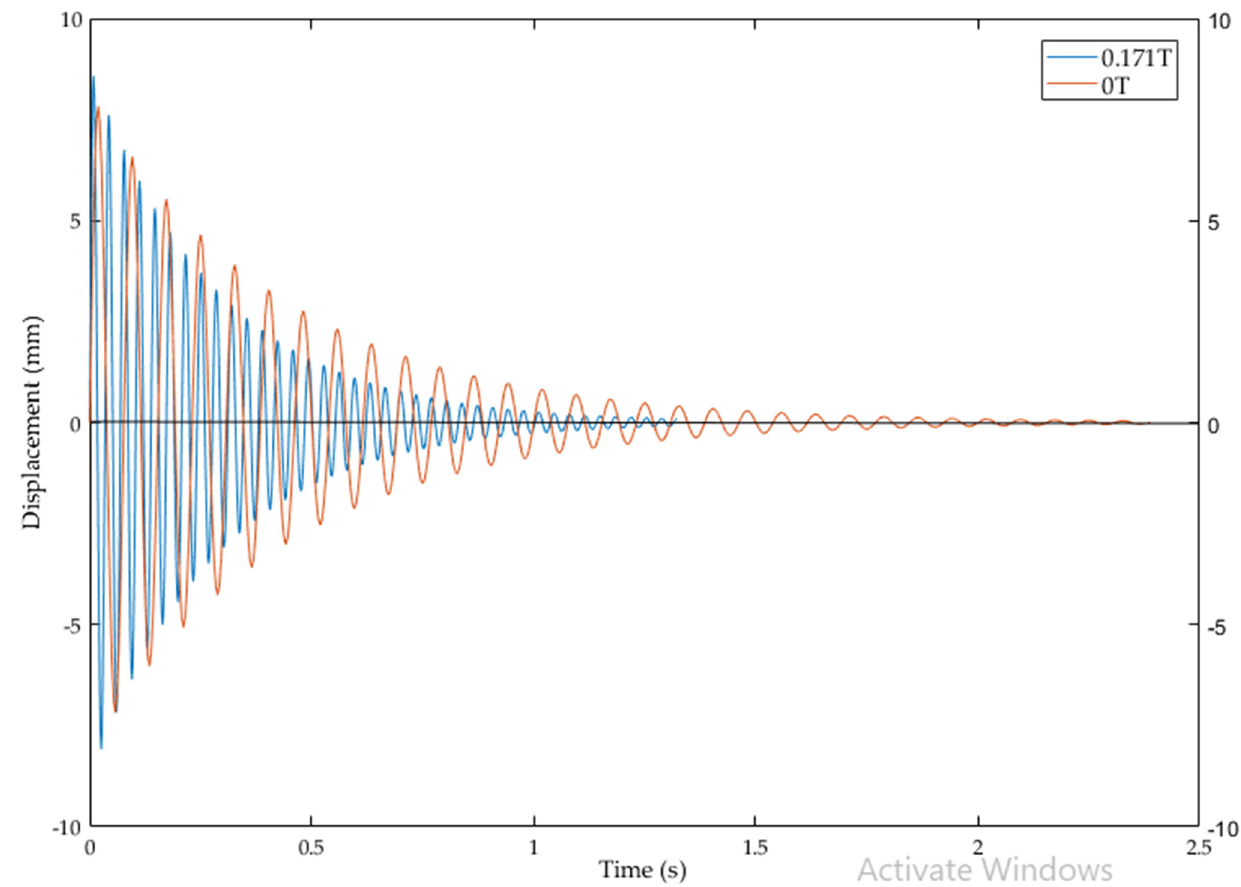
Figure 7. Vibration response of cantilever structure with MR fluid at 0 V (0 T) and 24 V (0.171 T). Materials 2021 , 14 , x FOR PEER REVIEW